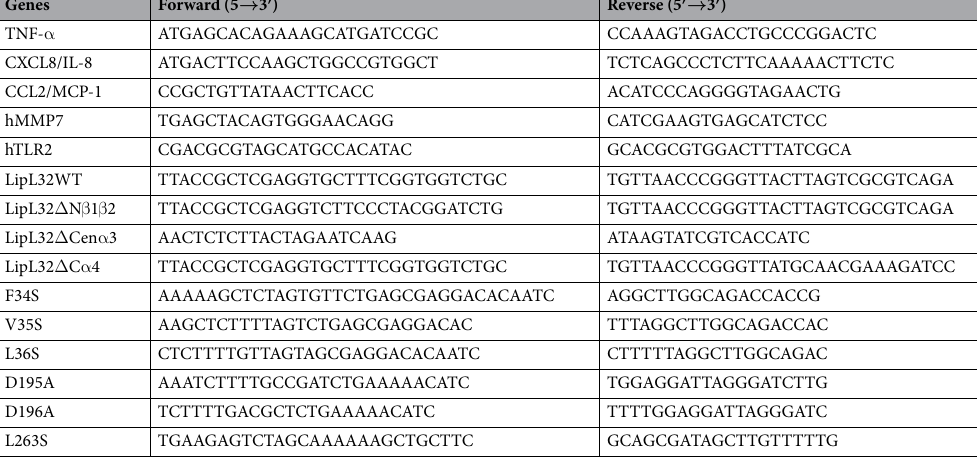
Table 1. Primers used in this